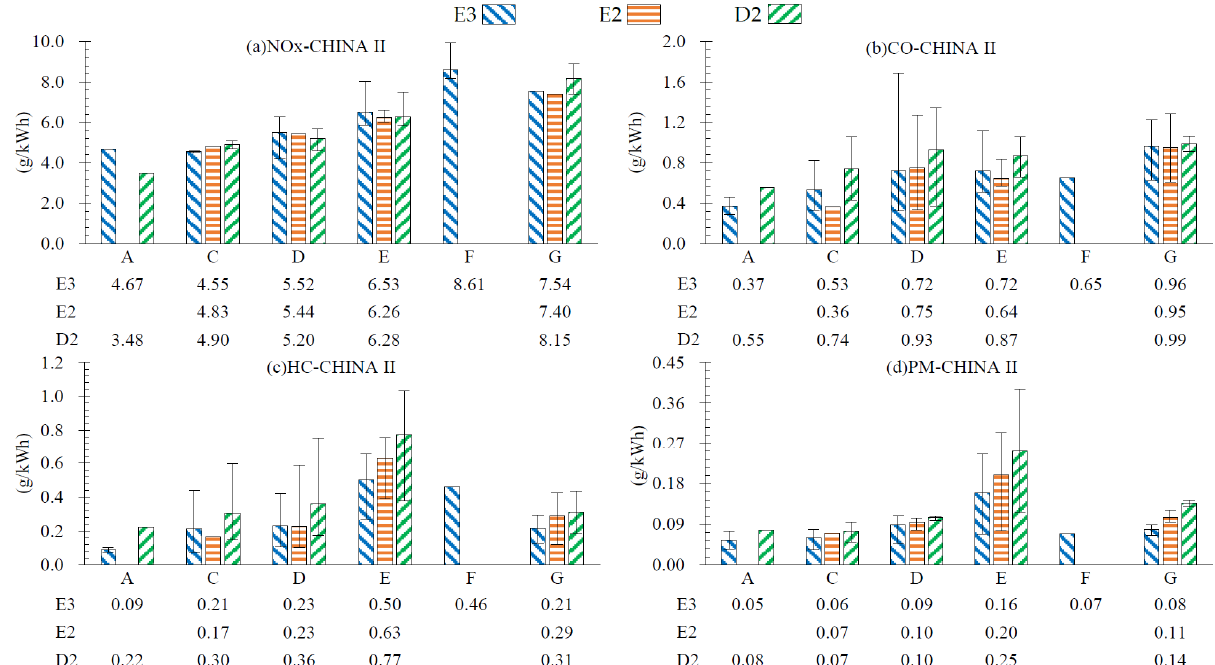
Figure 5. Energy-based emission factors for different single-cylinder displacements under the CHINA II standard. ( a ) NOx-specific emissions in the E3, E2, and D2 cycles; ( b ) CO-specific emissions in the E3, E2, and D2 cycles; ( c ) HC-specific emissions in the E3, E2, and D2 cycles; ( d ) PM-specific emissions in the E3, E2, and D2 cycles.